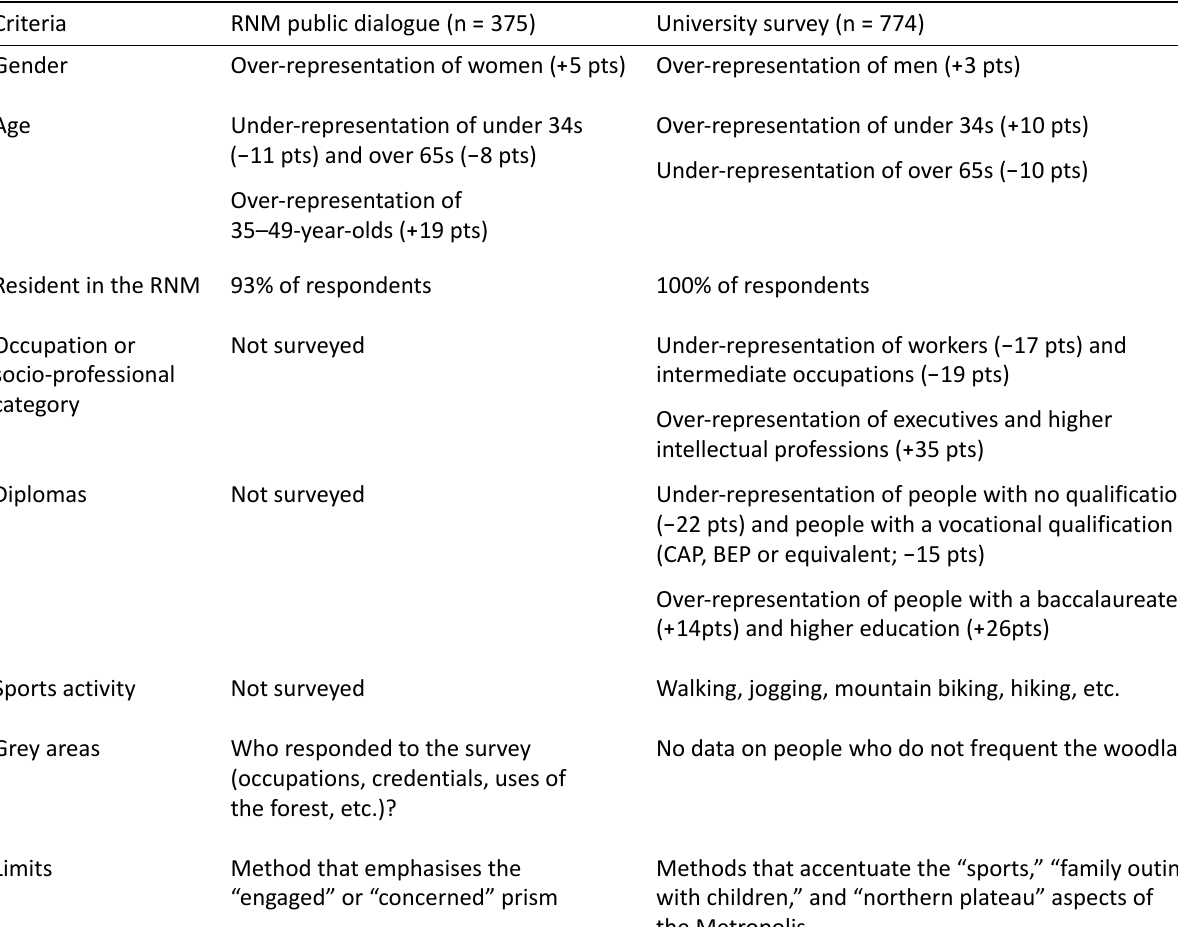
Table 2. Characteristics of the samples compared to the 2018 Metropolitan Population